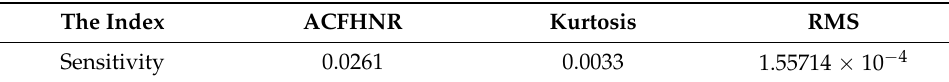
Table 3. The sensitivity value of the three indexes in the incipient fault stage.